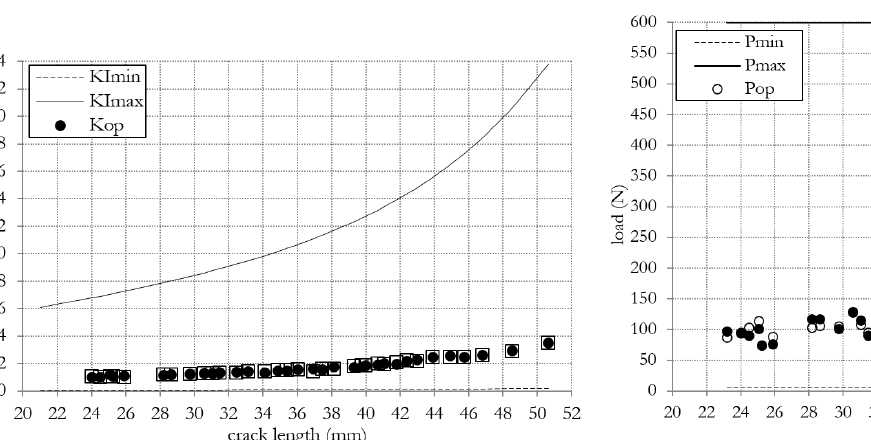
Figure 5: Estimated K op and K cl values as a function of the crack length for the specimen tested at low R -ratio.